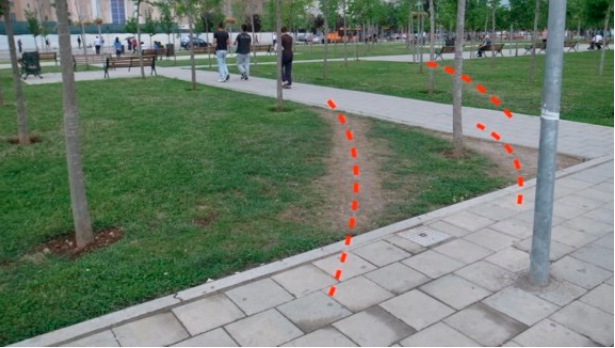
Figure 4. A modest example of stigmergy, where pedestrians build up pathway patterns over time that depart from what planners anticipate. Some planners revise their permanent structures based on these information patterns. Image: George Redgrave via Flickr.